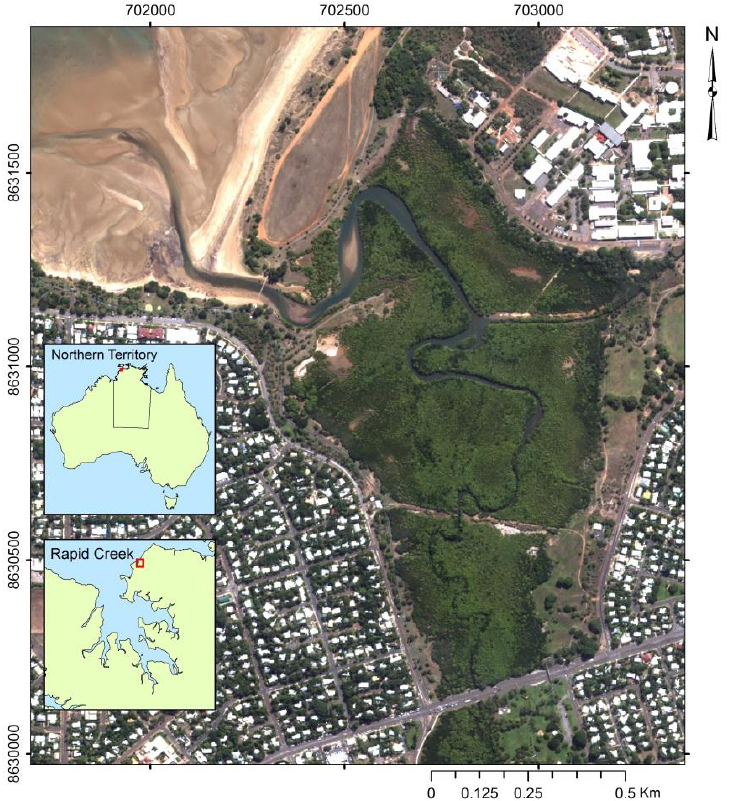
Figure 1. The study area located in coastal mangrove forest of Rapid Creek in Darwin, Northern Territory, Australia; WV2 data © Digital Globe. ( Coordinate system: Universal Transverse Mercator Zone 52 L, WGS84